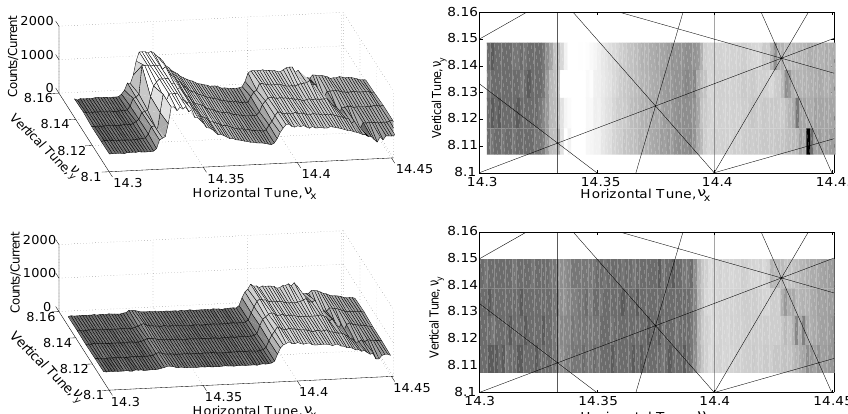
FIG. 10. Tune scans before (top) and after (bottom) the optic is corrected. At each horizontal and vertical tune, the count rate (as measured in a gamma counter) divided by beam current is plotted. The two data sets are drawn in both a hill (left) and a contour (right) plot. All resonances up to 5th order are drawn on the contour plot. no attempt to correct the coupling in the machine. In Fig. 11 a two dimensional plot is shown where the vertical axis is count rate divided by current and the bottom axis is horizontal tune. The vertical tune is kept roughly constant at n (cid:121) (cid:173) (cid:56)(cid:46)(cid:49)(cid:53) . In this picture we can more clearly see the relative amplitudes of the various resonances. A dramatic reduction in the (cid:51) n (cid:120) resonance can be seen after periodicity is restored.